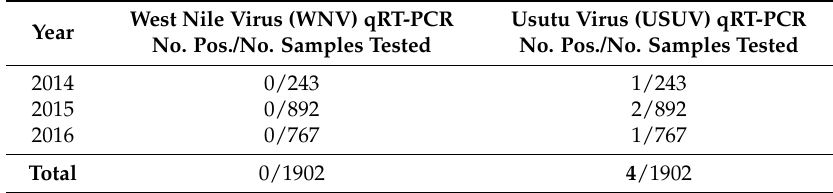
Table 2. Results of wild and zoo bird blood samples in quantitative real-time polymerase chain reactions (qRT-PCR) between 2014 and